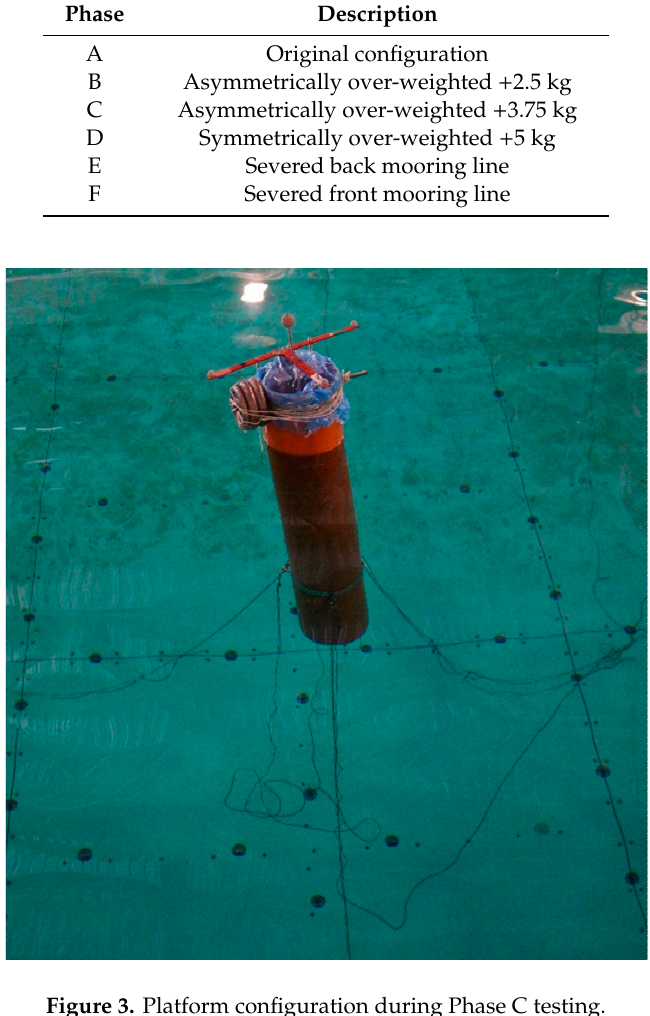
Figure 3. Platform configuration during Phase C testing.